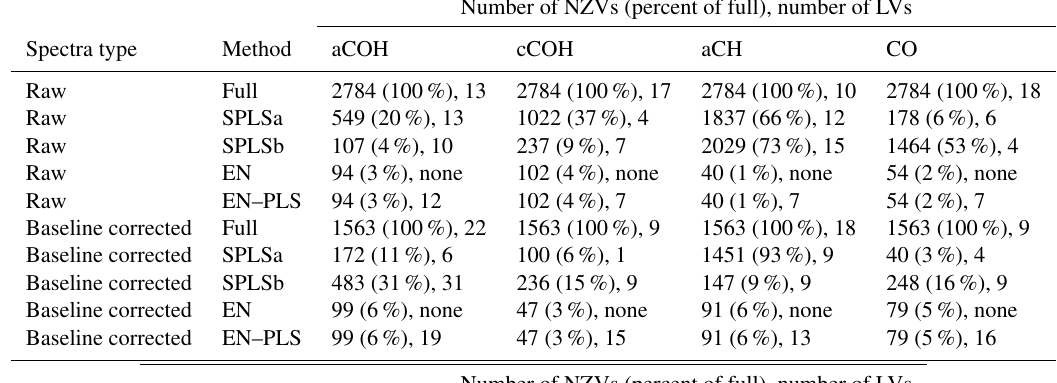
Number of NZVs (percent of full), number of LVs